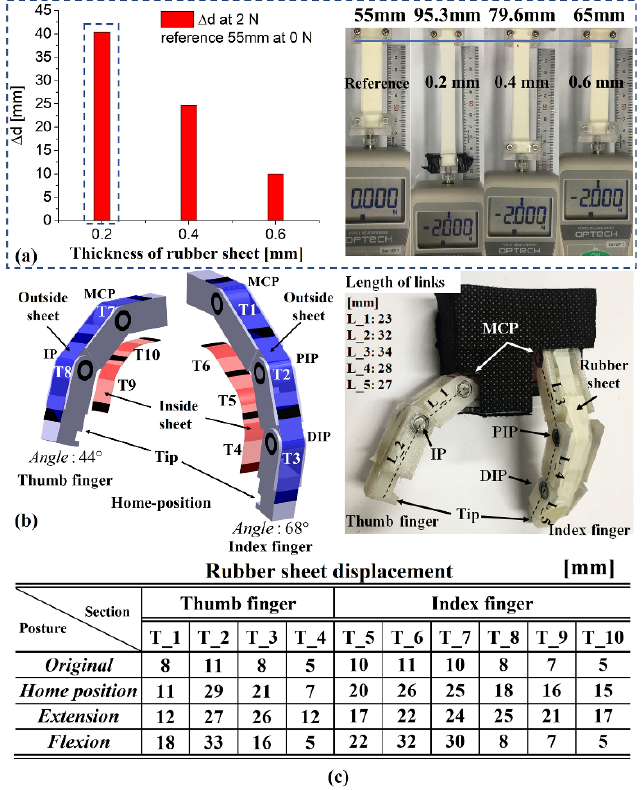
Figure 4. Basic properties of the rubber sheet: ( a ) displacements of the rubber sheet according to the sheet thickness at the applied force of 2 N. ( b ) Robotic finger structure and configuration. ( c ) Fabricated robotic finger: length of thin rubber pad and displacements at each posture (condition).